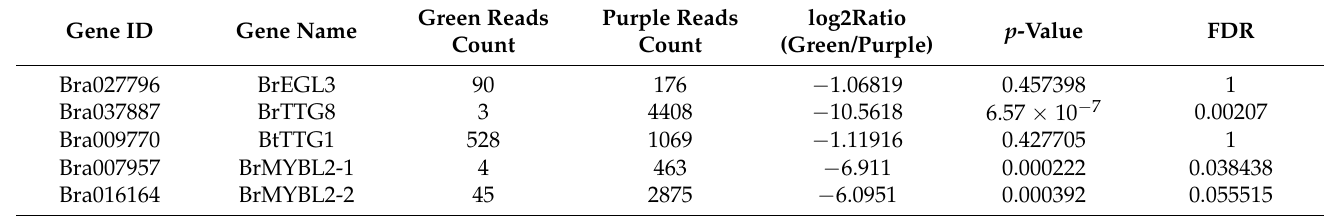
Table 2. Expression data of MYB and bHLH transcription factors in RNA-seq data as reported previously